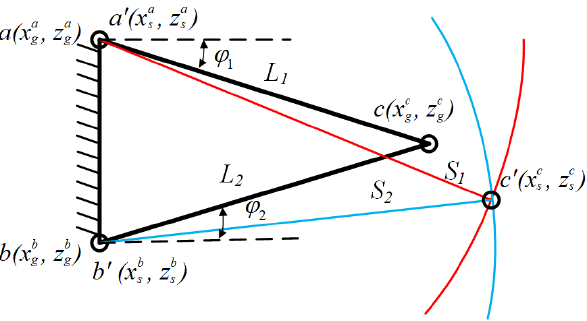
Figure 9. The deformation of truss rods in closed chain structure.